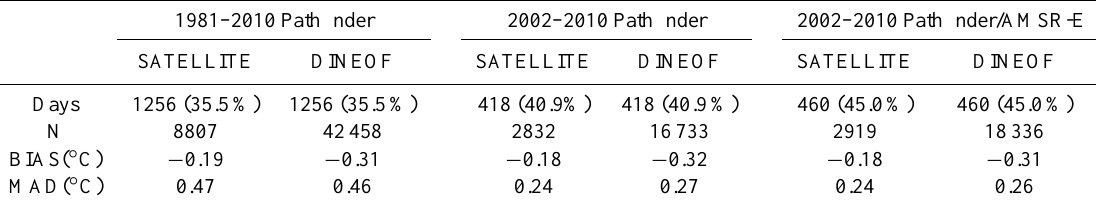
Table 1. Verification of the 1981–2010 Pathfinder, 2002–2010 Pathfinder and the 2002–2010 combined Pathfinder/AMSR-E DINEOF re- constructions using ICOADS SST data. In all three cases in situ observations are compared with the originally non-missing satellite values (SATELLITE) and with the fully reconstructed dataset (DINEOF). The number of reconstructed days together with the percentage of the total they represent in brackets, the sample size of each verification sub-sample (N), the bias (BIAS) and the median absolute deviation (MAD) are